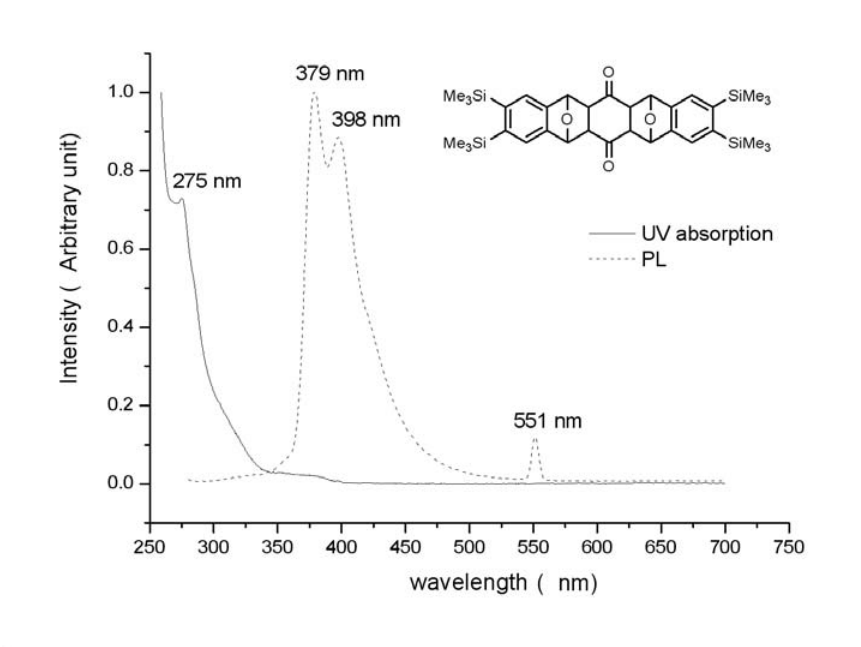
Fig. 2 The UV-VIS and PL spectra of compound 1